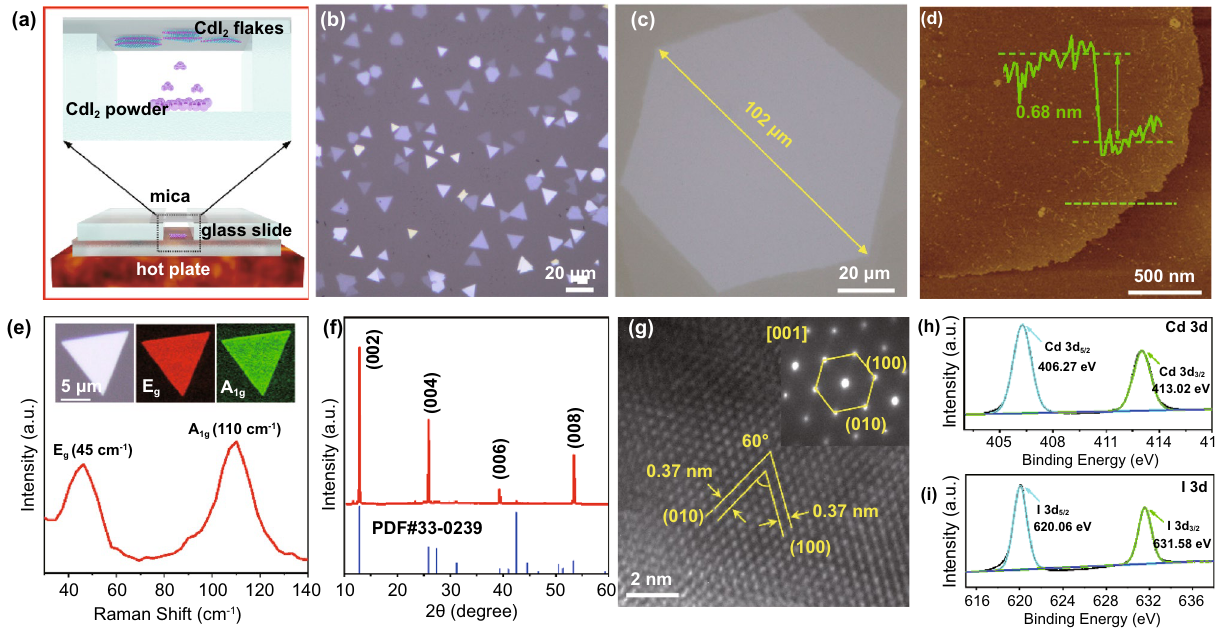
Fig. 2 Growth and characterization of layered CdI 2 flakes. a Schematic drawing of HPVVD setup for growth of CdI 2 flakes on mica substrate. b The typical OM image of large-area CdI 2 flakes grown on mica substrate showing both triangular and hexagonal geometry. c Representative OM image of a large-size CdI 2 flake with hexagonal shape on mica substrate. d AFM image and corresponding height profile of a typical monolayer CdI 2 . e Raman spectrum of CdI 2 flakes. The inset is the typical OM and Raman intensity mapping (E g and A 1g mode) of a triangular CdI 2 flake. f XRD pattern of CdI 2 flakes grown on SiO 2 /Si substrate. g HRTEM image of CdI 2 flakes. The inset is the SAED pattern taken along the direction [001] of